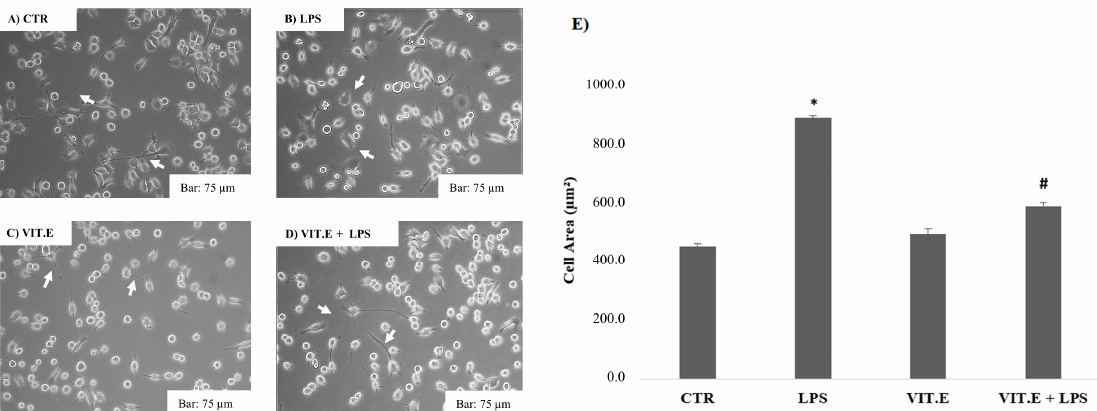
Figure 2. Morphological analysis after administration of vitamin E with or without LPS. Morpho- logical analysis of BV2 cells in the control condition ( A ) and after 1 µ g/mL LPS ( B ), 100 µ M vitamin E ( C ), or 100 µ M vitamin E in the presence of 1 µ g/mL LPS ( D ). Bar: 75 µ m (20 × objective). In the images, the arrows indicate cells that have undergone a morphological change. Cell areas ( µ m 2 ) were quantified using ImageJ software bounded with Java8 64-bit ( E ). Data are expressed as the means ± SDs of the cell areas. * p < 0.05 compared to control. # p < 0.05 compared to LPS.